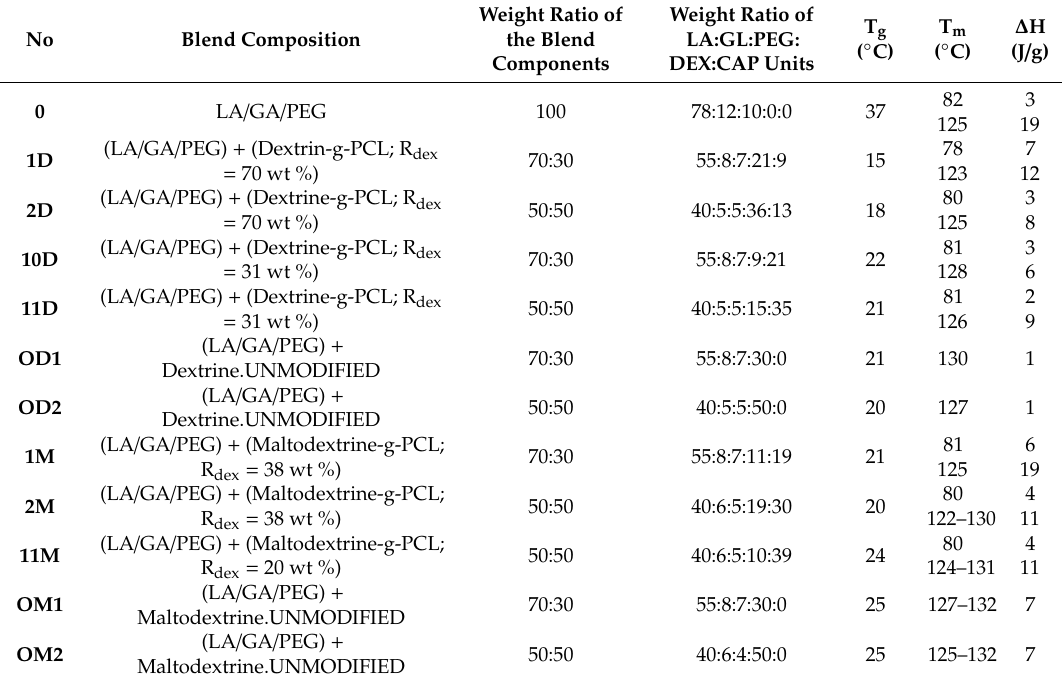
Table 2. Composition and thermal properties of polymer blends used in the